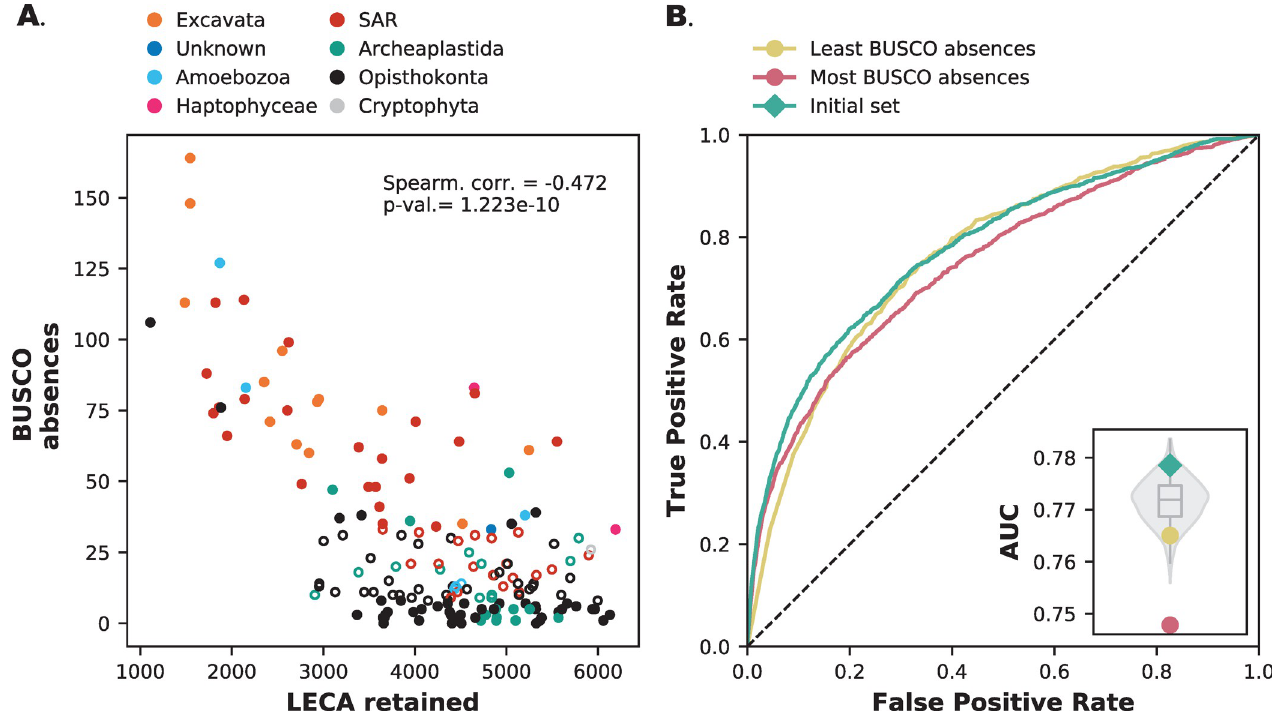
Fig 2. Lesser quality genomes have more impact on protein interaction prediction performance. A. BUSCO absences as a function of retained LECA OGs in different species. Filled data points are the selected genomes for the prediction accuracy calculations. B. Receiver-operator Curve of two species sets (n = 50) with the most and least BUSCO absences. The inset gives the Area Under the Curve (AUC) values compared with the random backdrop of 1000 random species sets (violin plot) and the initial species set (teal diamond). S2 Fig shows the results for Broccoli OGs.